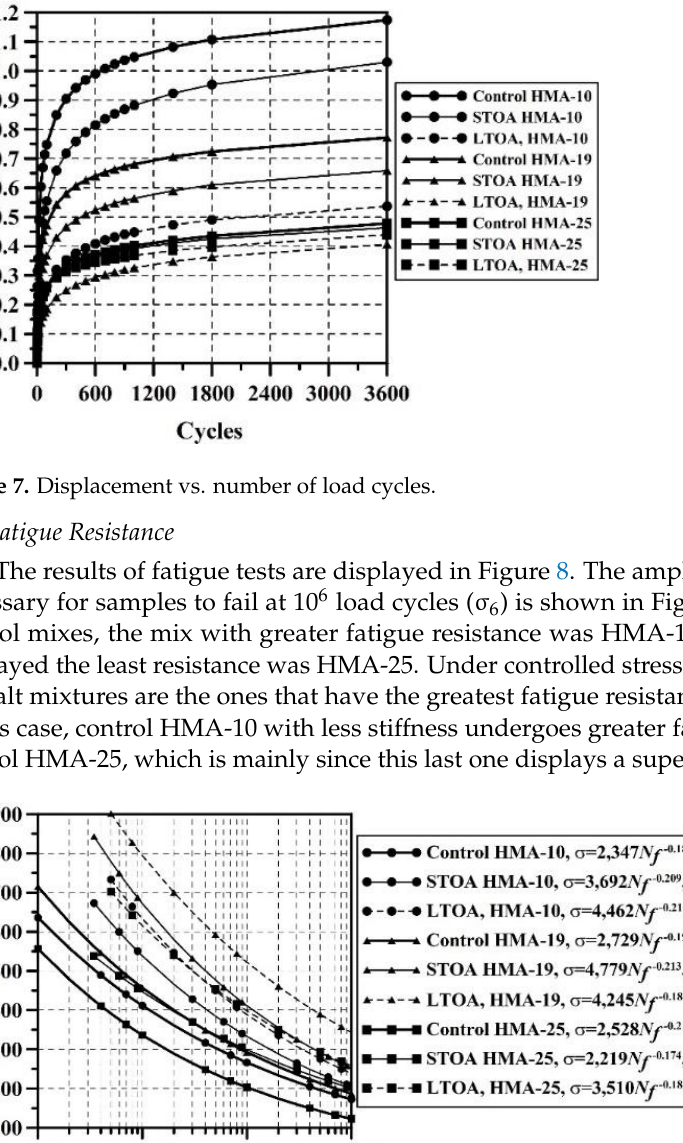
10 of 18 ( c ) Figure 6. RM LTOA /RM Control ratio at ( a ) 10 °C, ( b ) 20 °C, and ( c ) 30 °C. The permanent deformation resistance of a mix depends on a combination of factors such as asphalt binder type and stiffness, gradation, type form and texture of the aggre- gate, AV, and VFA, among others [68]. The results of the permanent deformation tests that are presented in Figure 7 are coherent with those obtained in the Marshall test and RM test. It is possible to observe an increase in permanent deformation resistance when mixes age as a product of the increase in stiffness in asphalt binder, increase in S/F ratio, and increase in RM. This increase in resistance can help to aid in resisting the rutting phe- nomenon in high-temperature climates [39]. The mix with the least rutting resistance is